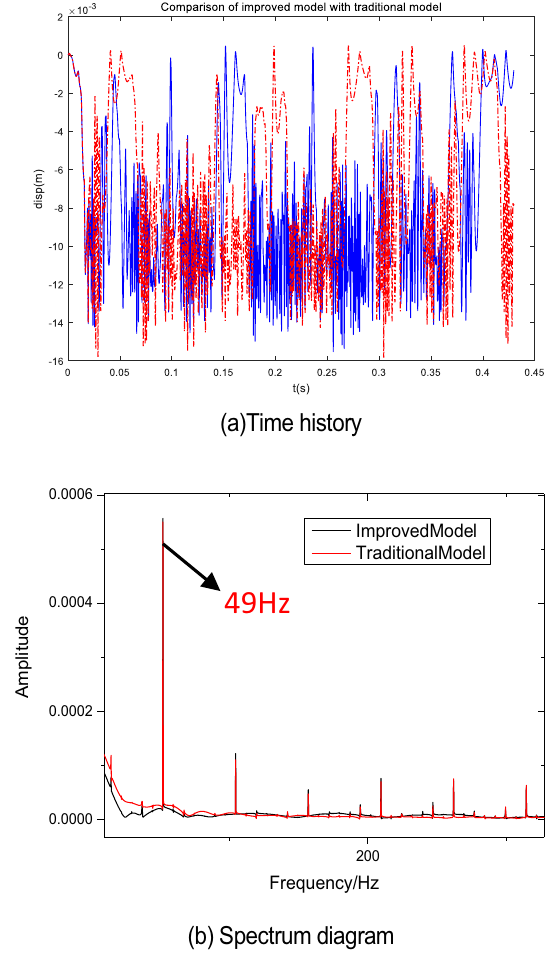
Fig. 3 Comparison of the new model with the traditional model a time history: the blue solid line is the response of the traditional model and the red dotted line is the response of the improved model; b spectrum diagram: the black figure is the improved model(new model) and the red figure is the traditional model (old